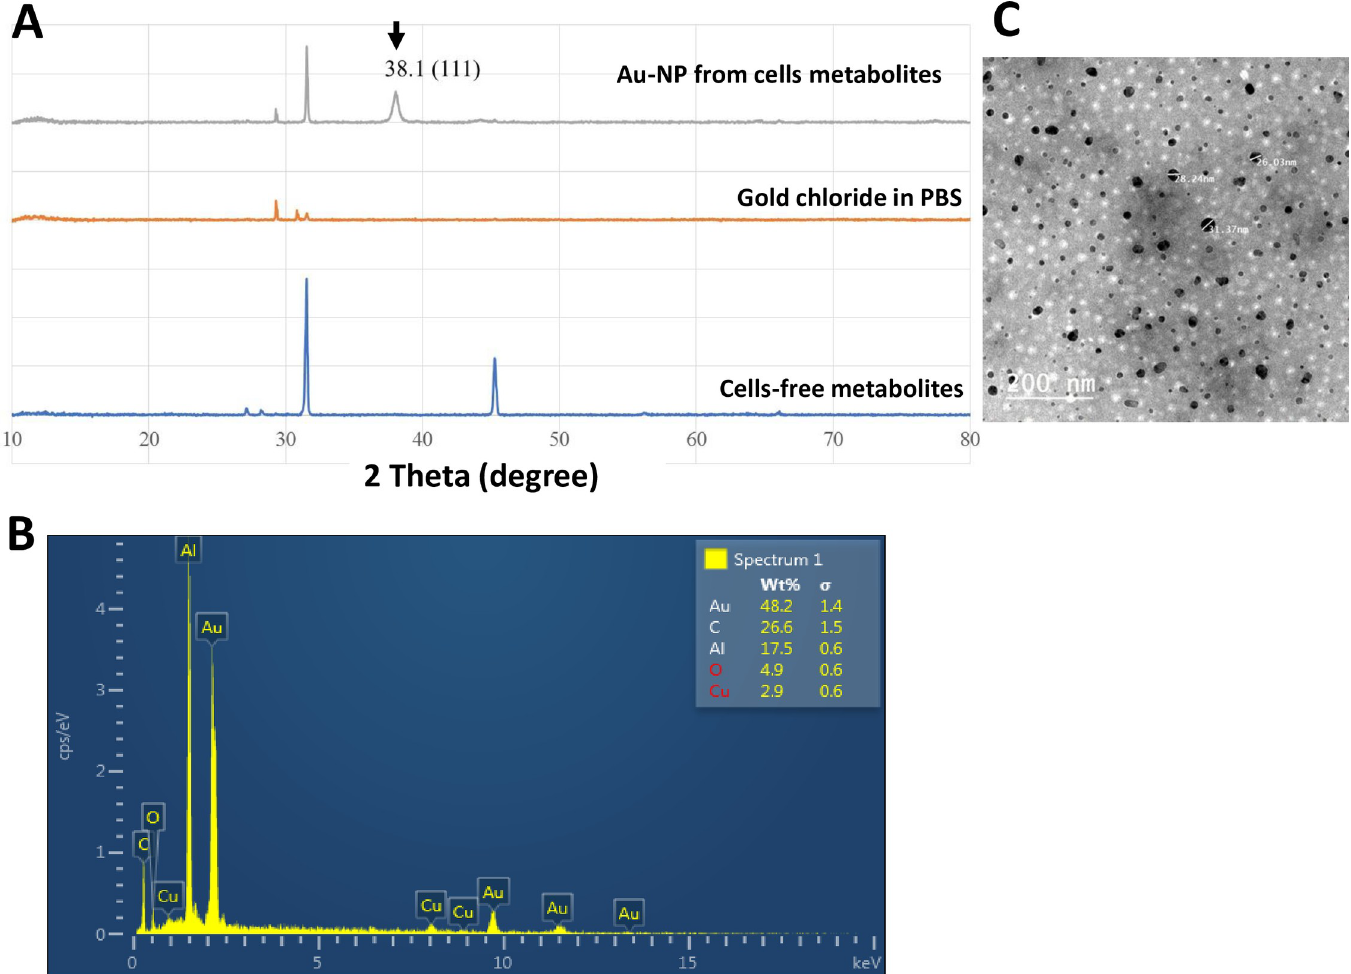
Fig 4. Characterization of AuNPs (AuNP2). (A) X-ray diffraction (XRD) patterns of the synthesized AuNPs. (B) SEM–EDS (energy dispersive spectroscopy) profile of the synthesized AuNPs. (C) TEM micrographs of AuNPs showed spherical-shaped particles. The samples of AuNPs were placed on standard carbon-coated copper grids (200-mesh) and air-dried for about 2h prior to